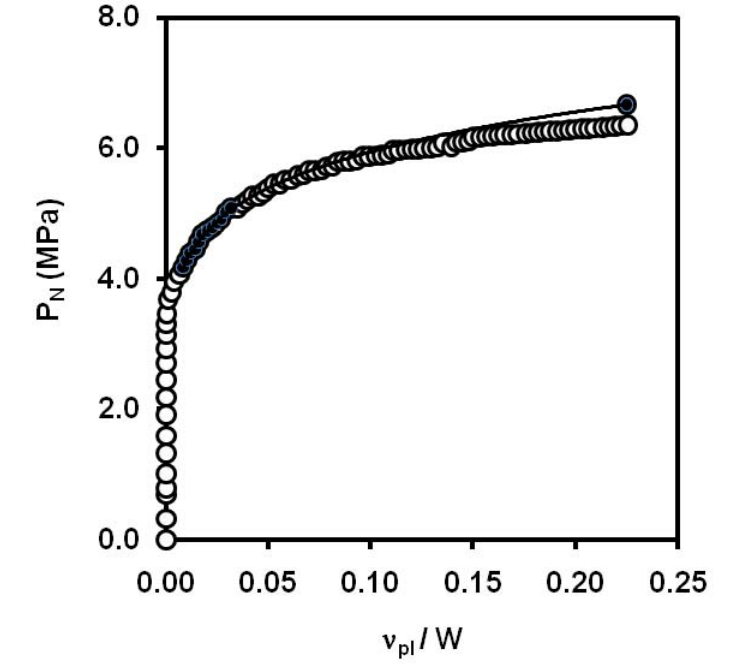
Figure 31. Graphic determination of the limits of the separation blunting region for a , 40 wt.% composite (adapted from [110]). PP/Mg(OH) 2